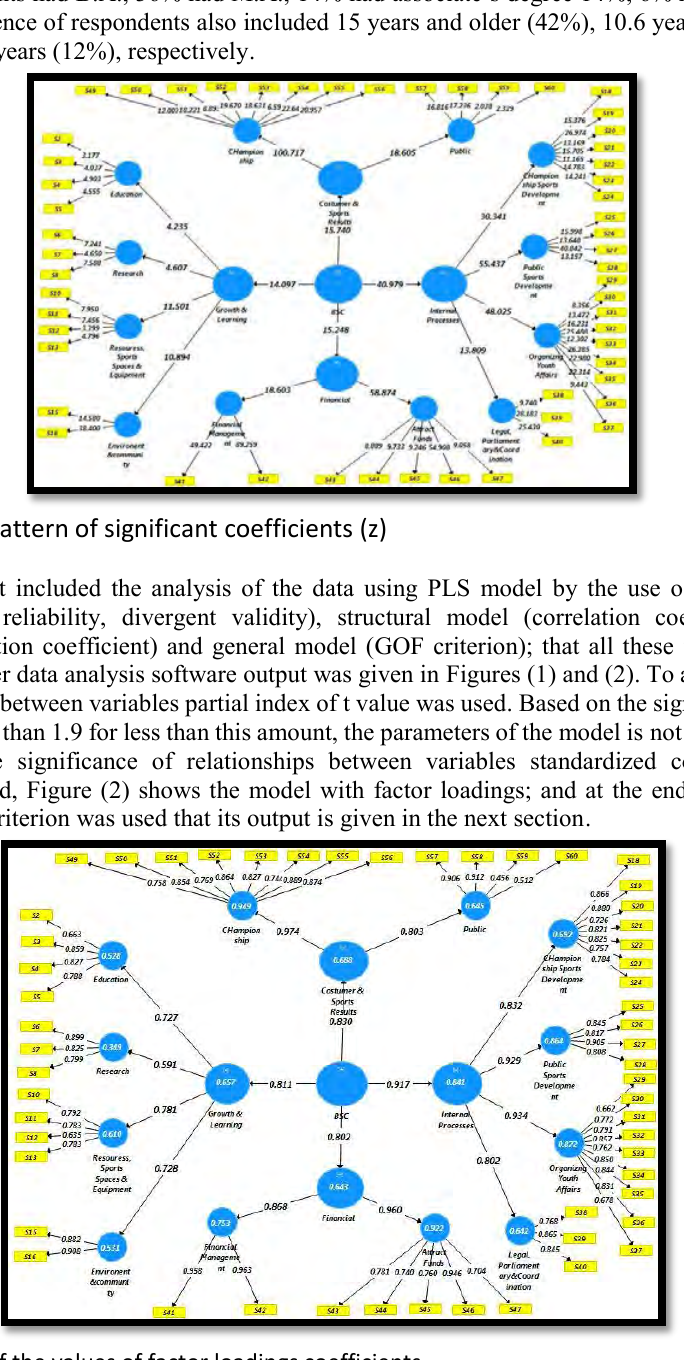
Figure2. The pattern of the values of factor loadings